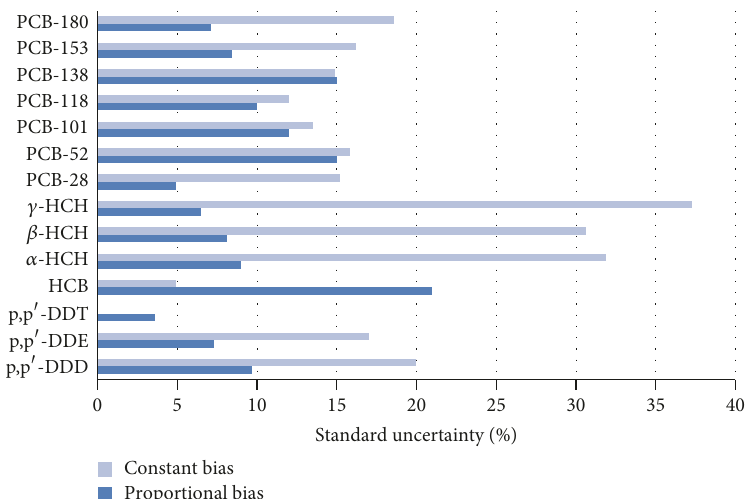
Figure 5: Standard uncertainty for constant and proportional bias contributions for the analysis of selected pesticides and PCBs in